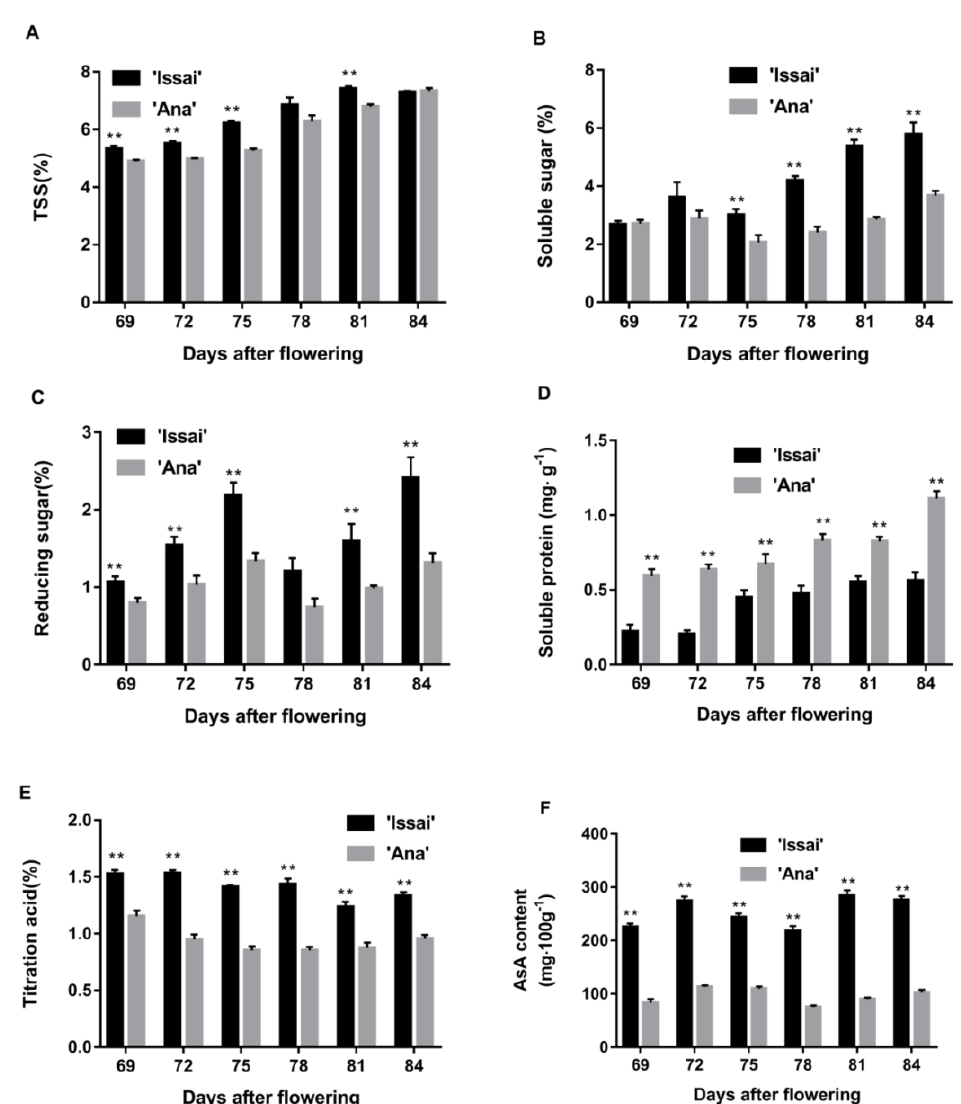
Figure 3. The effect of maturity stage at harvest on changes in TSS ( A ), soluble sugar ( B ), reducing sugar ( C ), soluble protein ( D ), titration acid ( E ), and AsA content ( F ). Data are presented as mean ± standard error from three biological replicate assays (** p < 0.01). The error bars represent standard error of the means.